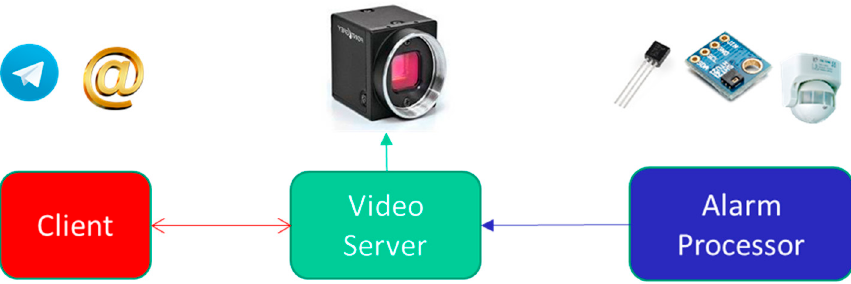
Figure 1. Scheme of main components of the video surveillance system.